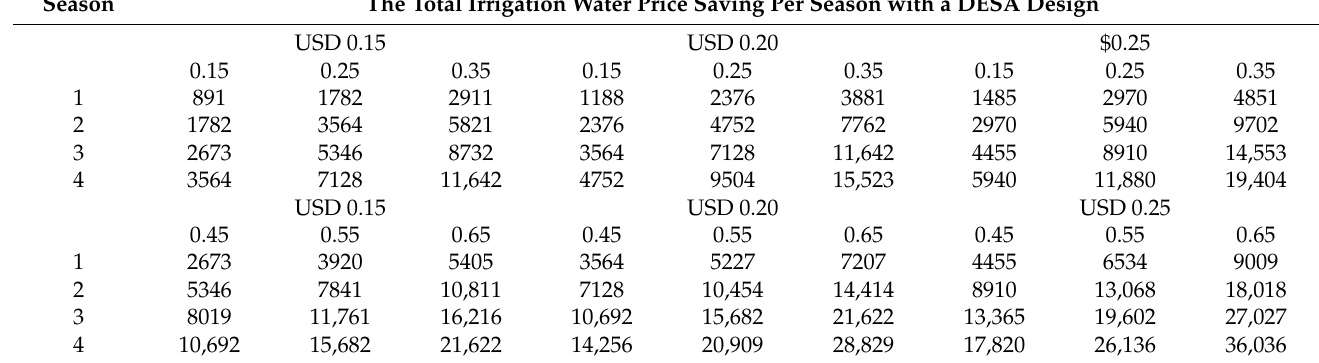
Table 9. Irrigation water saving per season at three percentage assumptions for water-saving by using a DESA design with center pivot irrigation at different water prices with climate change in the